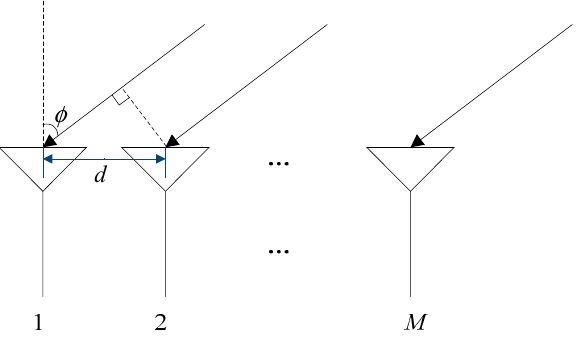
Figure 18. Antenna array schematic.